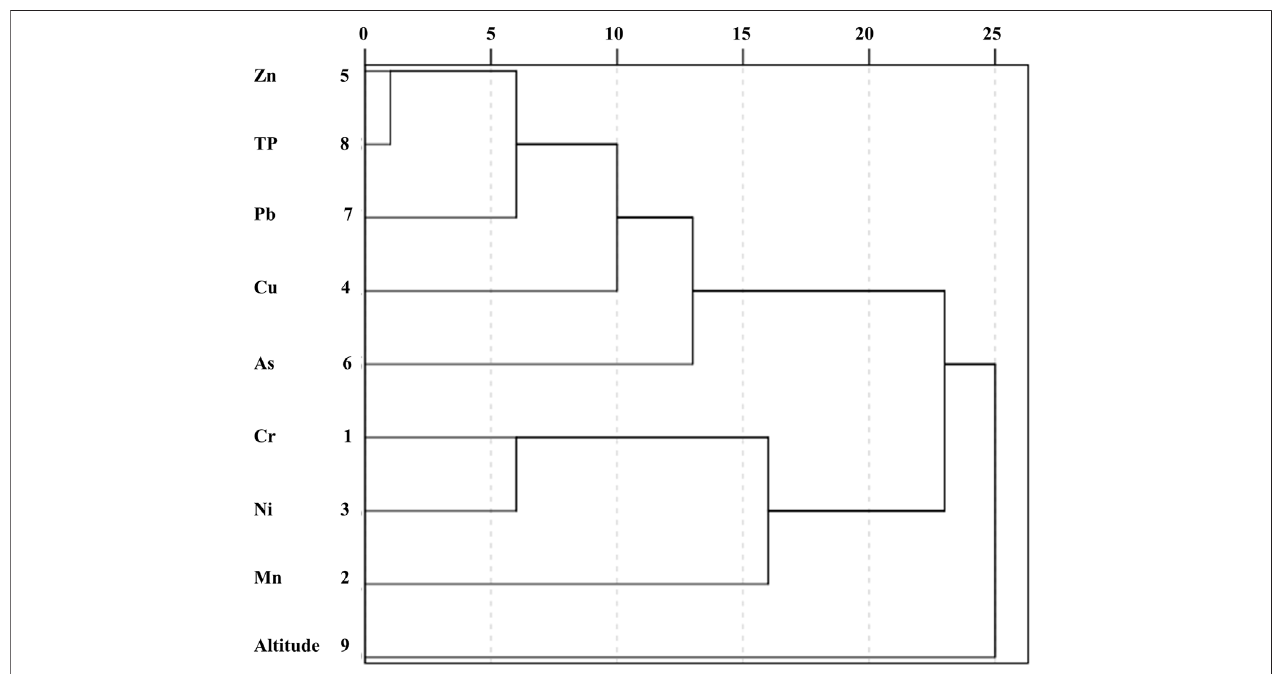
FIGURE 5 | Heavy metal cluster analysis (CA) dendrogram.